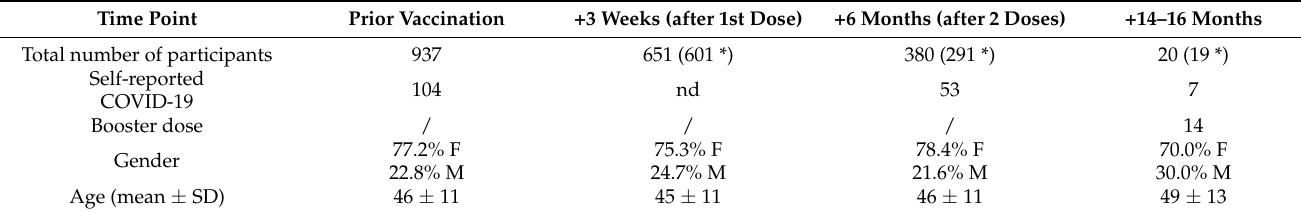
Table 1. Demographic characteristics and vaccination status of the studied HCW